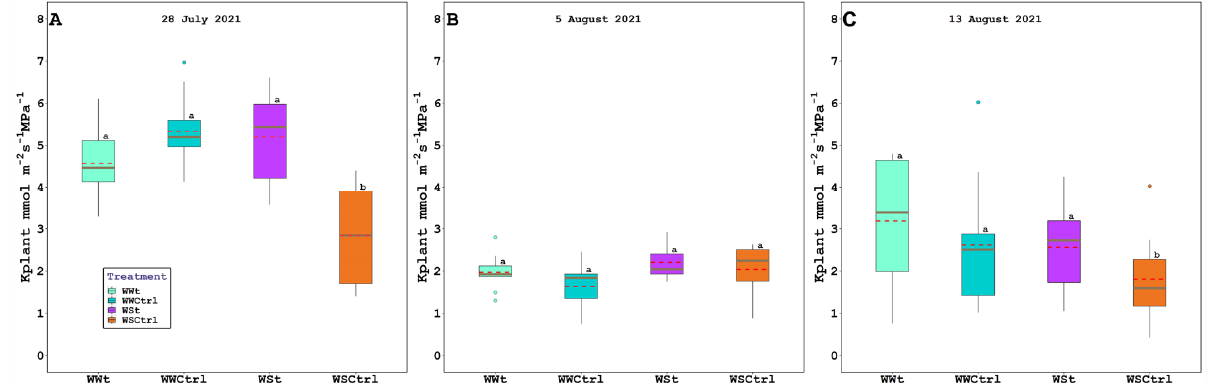
Figure 5. Plant hydraulic conductivity (Kplant; mmol m − 2 s − 1 MPa − 1 ) in Vitis vinifera treated with Zeolite (t) and untreated plants (Ctrl), under two irrigation regimes (WW, well-watered; WS, water- stressed); ( A ). 28 July 2021, ( B ). 5 August 2021, and ( C ). 13 August 2021. The box bounds show the 25 and 75 percentiles, and the error bars the 90 and 10 percentiles. The black continuous and red discontinuous lines inside the boxes represent medians and means, respectively. Outliers are repre- sented as color dots. Average values with the same letter in each figure indicate no significant dif- ferences between plots ( p < 0.05).